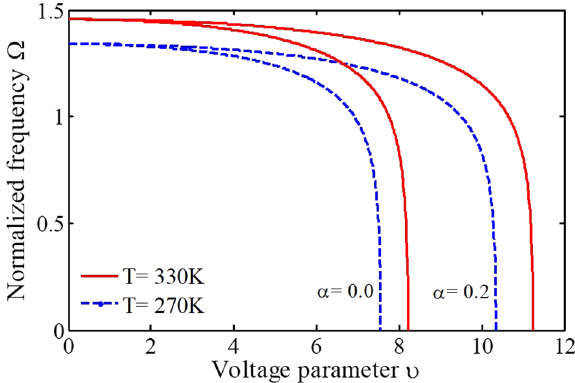
Figure 7. The impact of adherent biological particles on the sensor behavior at different